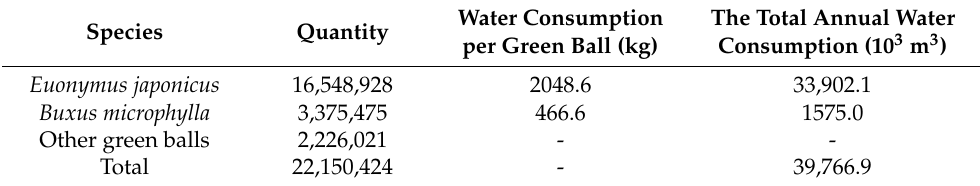
Table 12. Annual water consumption of green balls in Beijing.